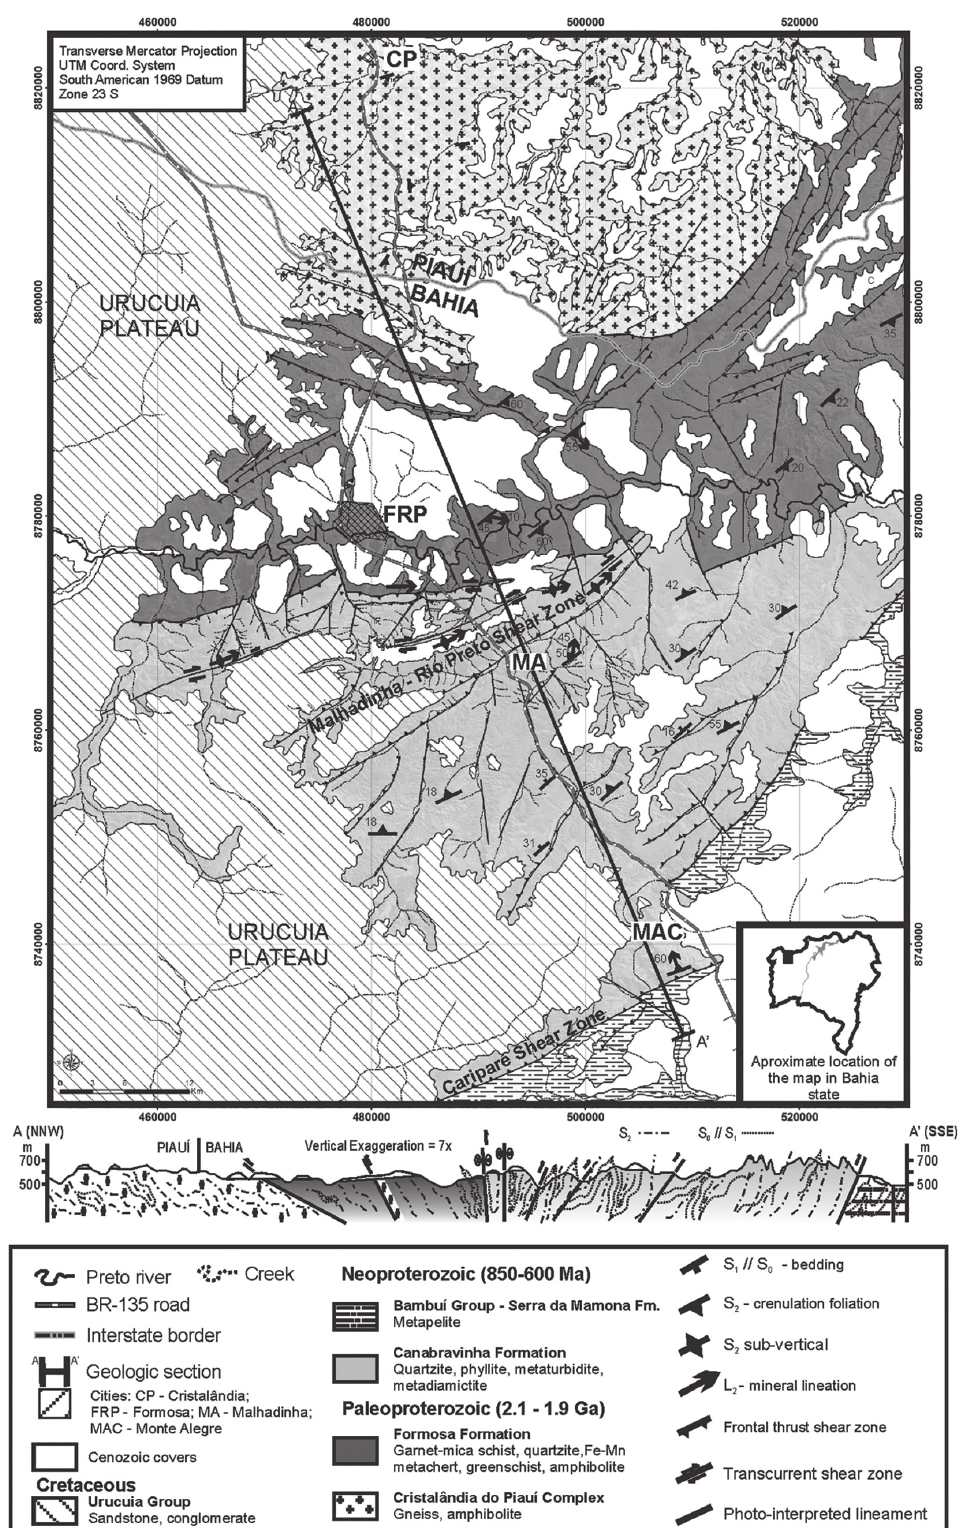
Figure 2 - Geological map and cross section of the Rio Preto fold